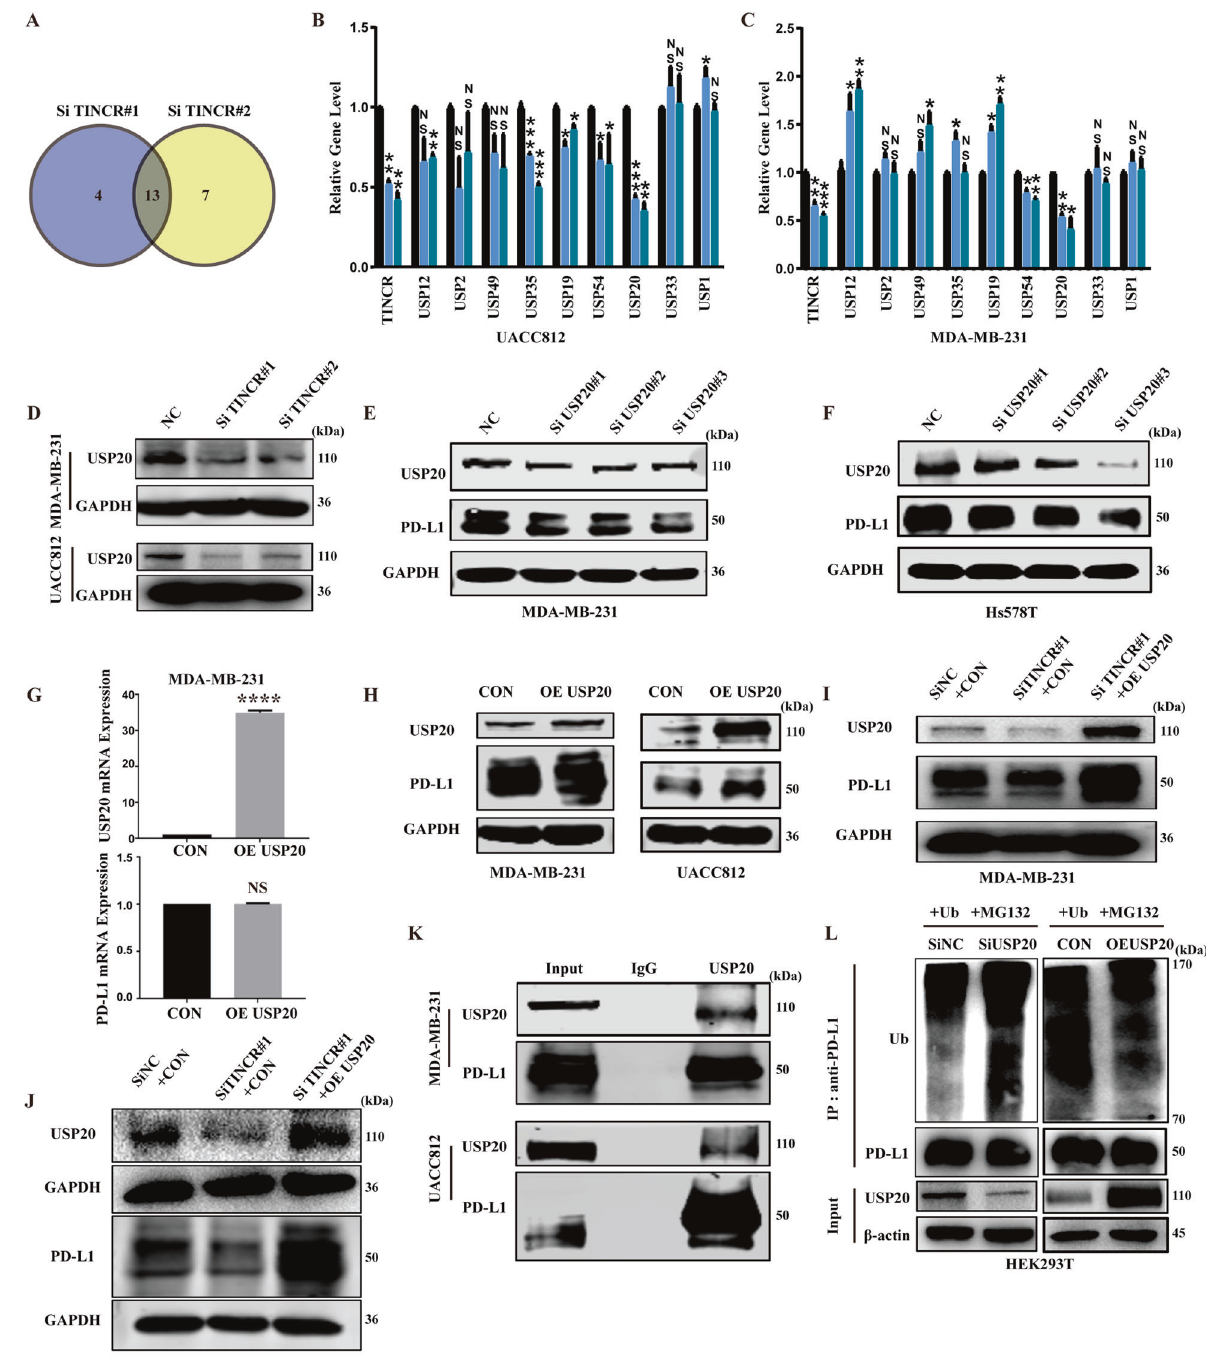
Fig. 3 TINCR recruits USP20 to stabilize PD-L1. A Transcriptome sequencing in T47D cells after TINCR knockdown. B , C RNA expression of different deubiquitinases after TINCR knockdown in MDA-MB-231 and UACC812 cells. D USP20 protein expression after TINCR knockdown. E , F PD-L1 protein expression after USP20 knockdown. PD-L1 expression in ( G ) mRNA and ( H ) protein levels after USP20 overexpression in MDA-MB-231 cells. I , J Detection of PD-L1 expression after TINCR knockdown and USP20 overexpression. K CO-IP experiments con fi rmed that USP20 binds to PD-L1. L Ubiquitination assay of PD-L1 in control, USP20-knocked, and USP20-overexpressing HEK293T cells co-transfected with Ub and treated with MG132. Data are presented as means from three independent experiments ± S.D. * P < 0.05, ** P < 0.01, *** P < 0.001, **** P <